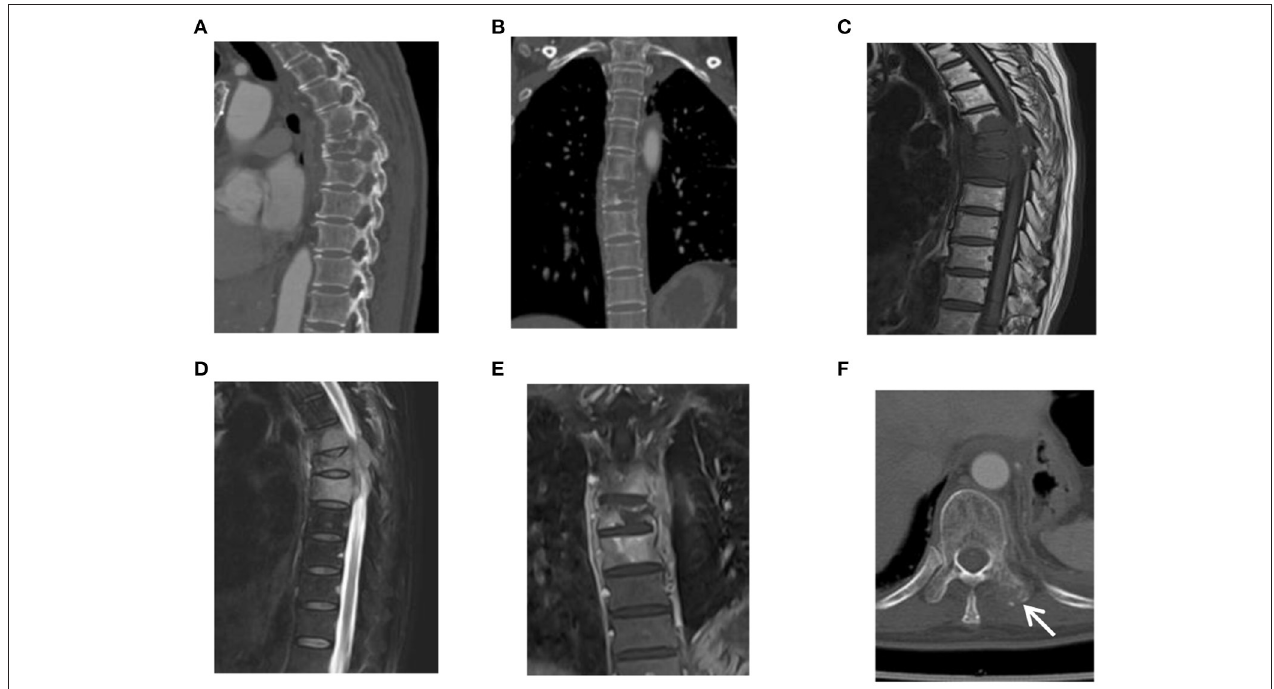
FIGURE 3 | CT and MRI of a 49-year-old female patient with mediastinal EHE before the second treatment. (A–D) CT (A,B) , and MRI (C,D) revealed multifocal lesions of the thoracic vertebrae 5–7. (E) An enhanced MRI of the venous phase revealed multifocal lesions of the thoracic vertebrae with obvious asymmetrical enhancement. (F) The CT indicated a local ruin of the left transverse process of the 10th thoracic vertebra (arrow).